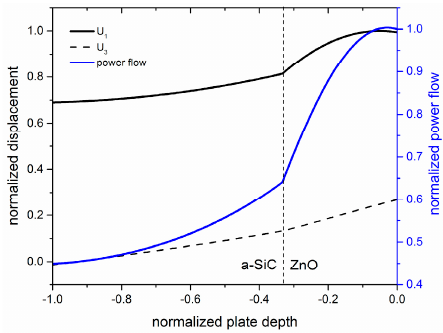
Figure 3. The power flow, and the longitudinal and shear vertical particle displacement components, U 1 and U 3 , of the qS 0 mode propagating along an a-SiC plate with h aSiC / λ = 0.1, covered by a ZnO layer with h ZnO / λ = 0.05.